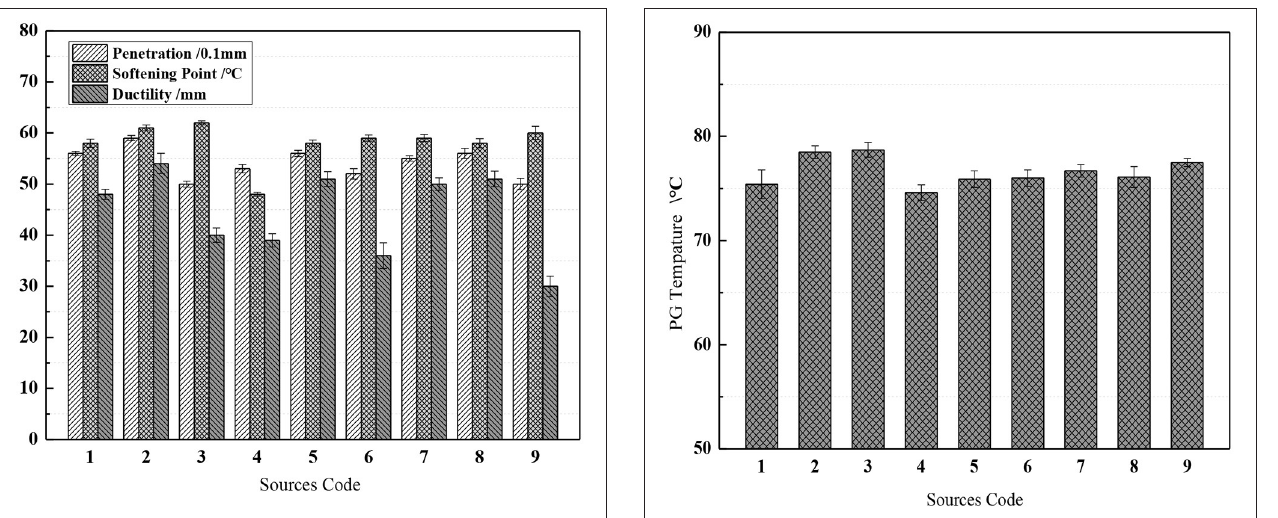
FIGURE 3 | Test result of TPU modified asphalt.